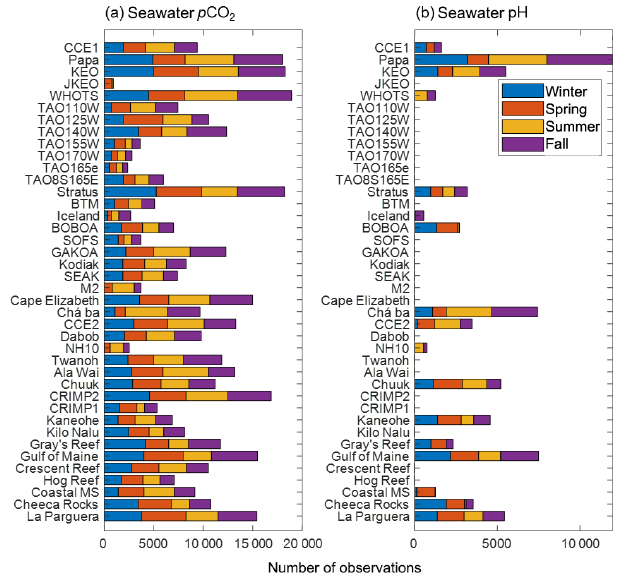
Figure 3. Number of surface seawater (a) p CO 2 and (b) pH obser- vations by season in each of the 40 moored time series. For North- ern Hemisphere sites, winter is defined as December, January, and February; spring is March, April, and May; summer is June, July, and August; and fall is September, October, and November (seasons reversed for Southern Hemisphere sites). The number of observa- tions for Dabob and Twanoh shown here are seawater x CO 2